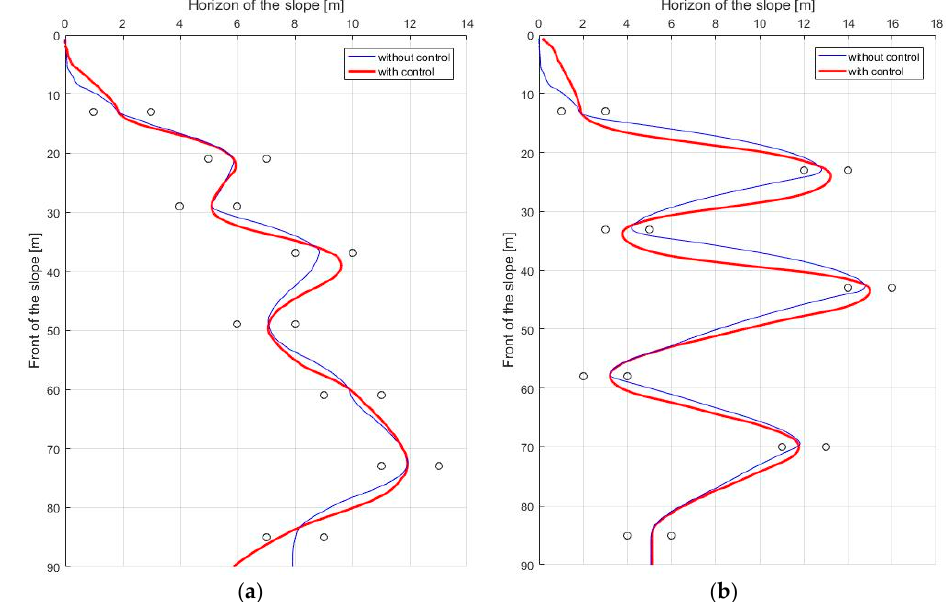
Figure 11. The trajectory of the skiing robot ( a ) Short interval; ( b ) Long interval.